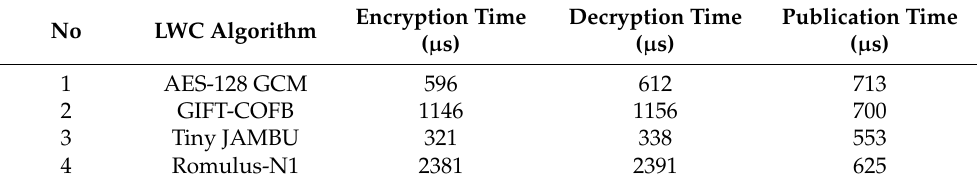
Table 5. Lightweight Cryptographic Encryption and Decryption Performance on NodeMCU with 20 Characters Messages used Anonymous